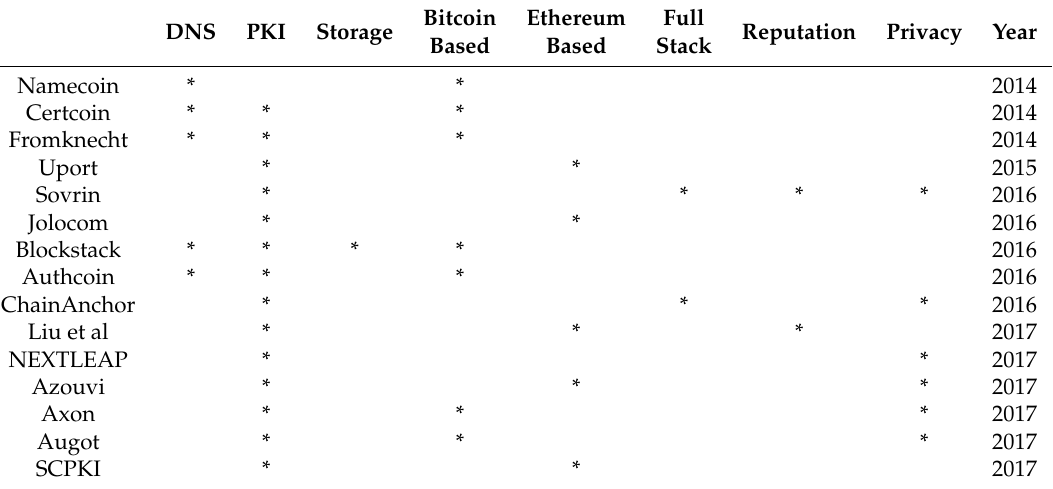
Table 2. Blockchain identity management